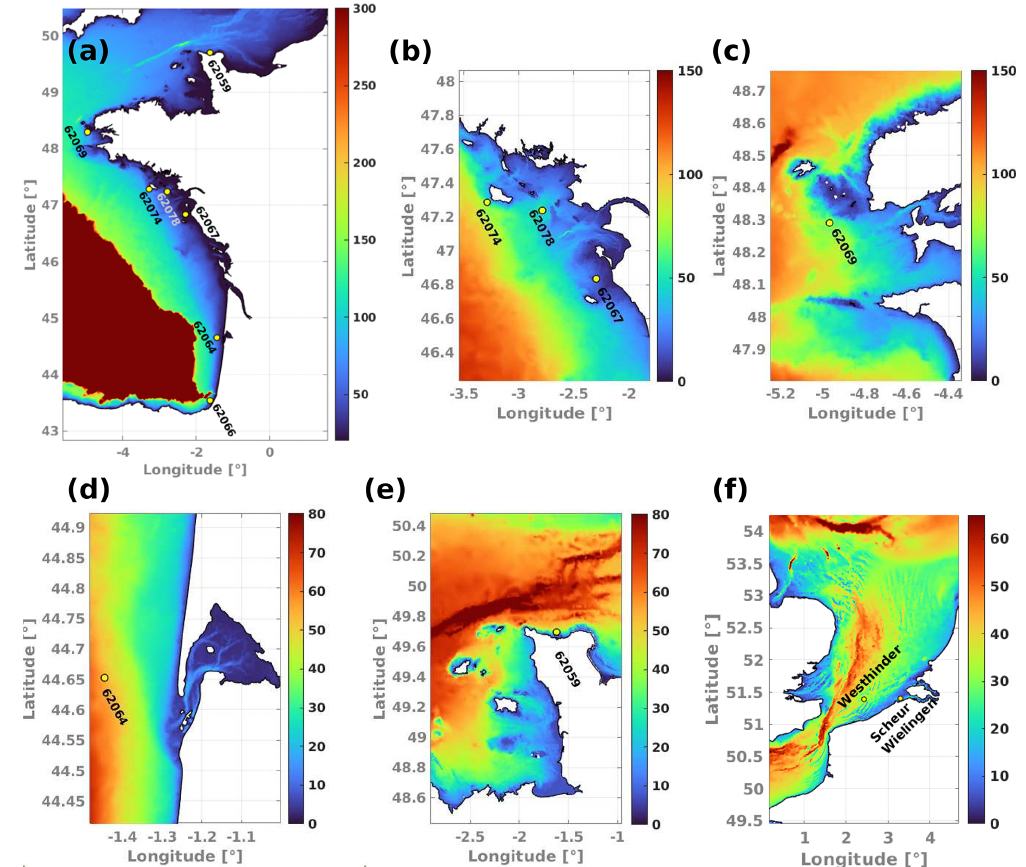
Figure 4. Buoy location and bathymetry features. (a) Buoys along French coast. (b–e) Details of French buoy locations. (f) Detail of Belgian buoy location. Color bar shows depths in meters with respect to mean sea level. Maximum depth on each panel has been selected to enhance bathymetry